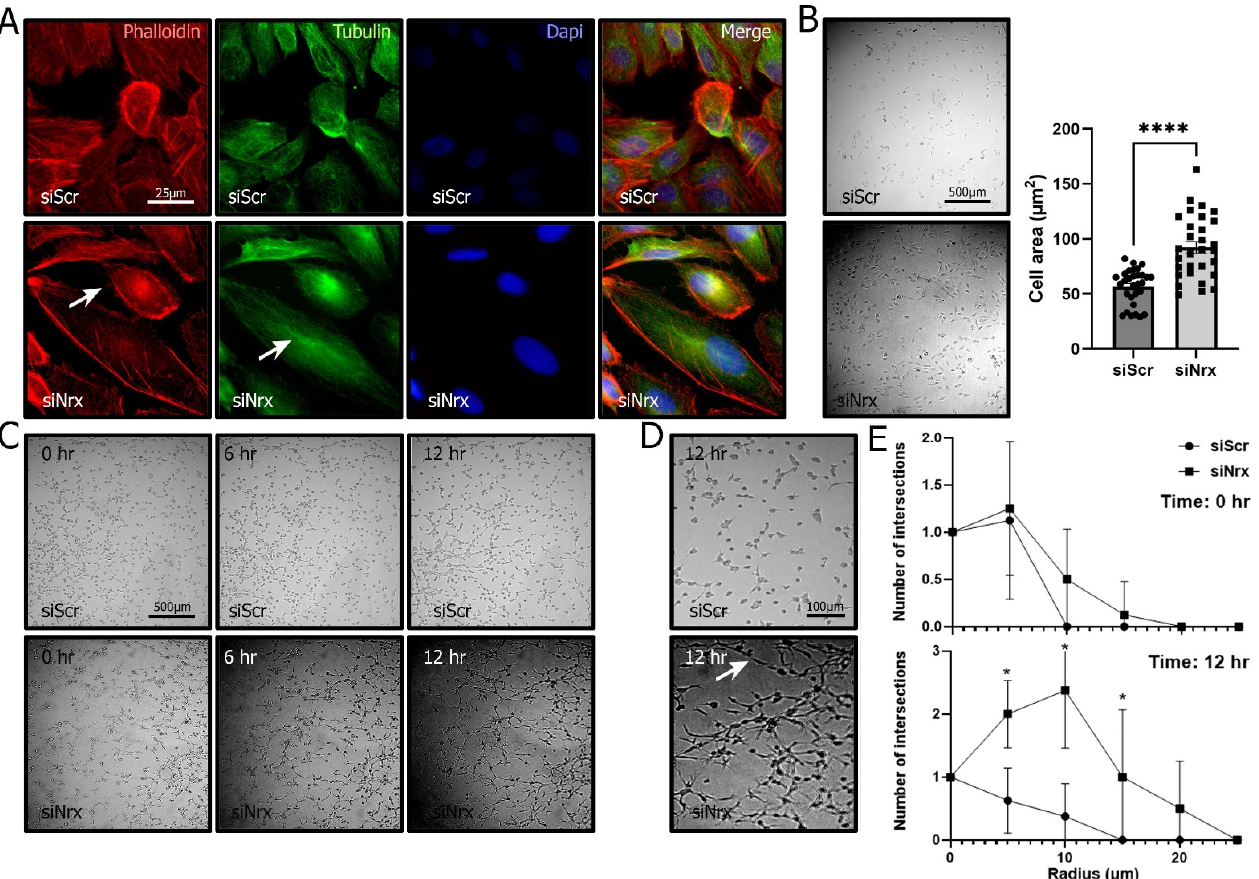
Figure 4. Nrx knock-down affects ARPE19 morphology and number of protrusions. ( A ). Immunoflu- orescence staining of the cytoskeleton: Actin (phalloidin, red), Tubulin (green) and nuclei counter- staining (Dapi, blue) in siScr and siNrx ARPE-19 cells. ( B ). Light microscopy area analysis of siScr and siNrx ARPE-19 ( p = < 0.0001; n = 40–50). ( C , D ). Light microscopy photographs of 3D morphology analysis at different time points of siScr and siNrx ARPE-19 cells. ( E ). Sholl analysis of siScr and siNrx ARPE-19 cells at 0 h and 12 h after plating ( p = 0.000128, 0.000098, 0.019188; n = 20). Bars and error bars represent the mean + standard deviation (SD). *, **** Asterisks indicate different levels of